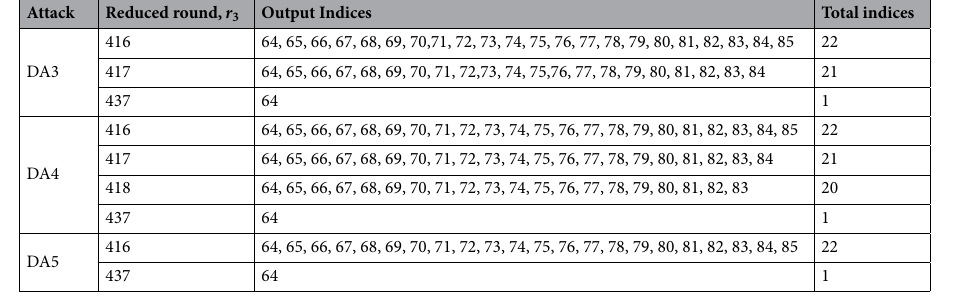
Table 10. Experimental results of 32-bit cube for DA3, DA4 and